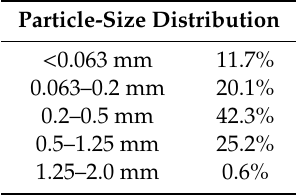
Table 2. Pulverized bark sample particle-size